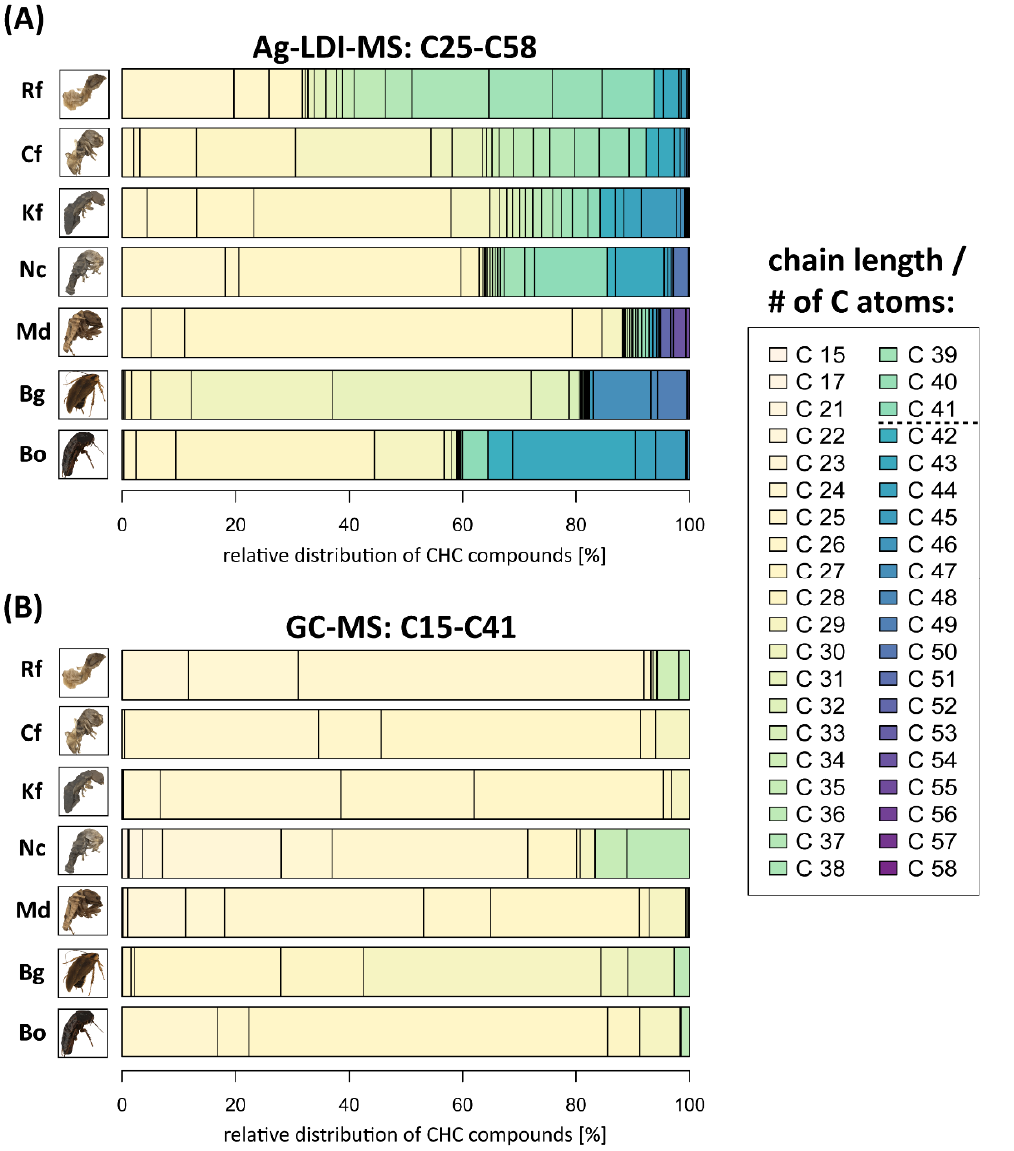
Figure 2. Relative distributions (in percentages) of CHC compounds in our seven studied Blattodea species grouped by chain length/number of C atoms. ( A ) C25–C58 range, obtained by the signal intensities measured with Ag ‐ LDI ‐ MS. ( B ) C15–C41 range, obtained by CHC quantities measured by standard GC ‐ MS methodology. Note that signal intensities in terms of quantification in both methods are not directly comparable, hence only relative distribution ranges are given. Ranges in chain lengths/number of C atoms are indicated by a color gradient (light yellow to dark violet for lowest to highest chain length/number of C atoms, respectively). A dotted line between C41 and C42 in the legend indicates the chain length/number of C atoms detection limit for standard GC ‐ MS methodology,. Insect images have been obtained from their DISC3D scans (Figure S1). Rf: